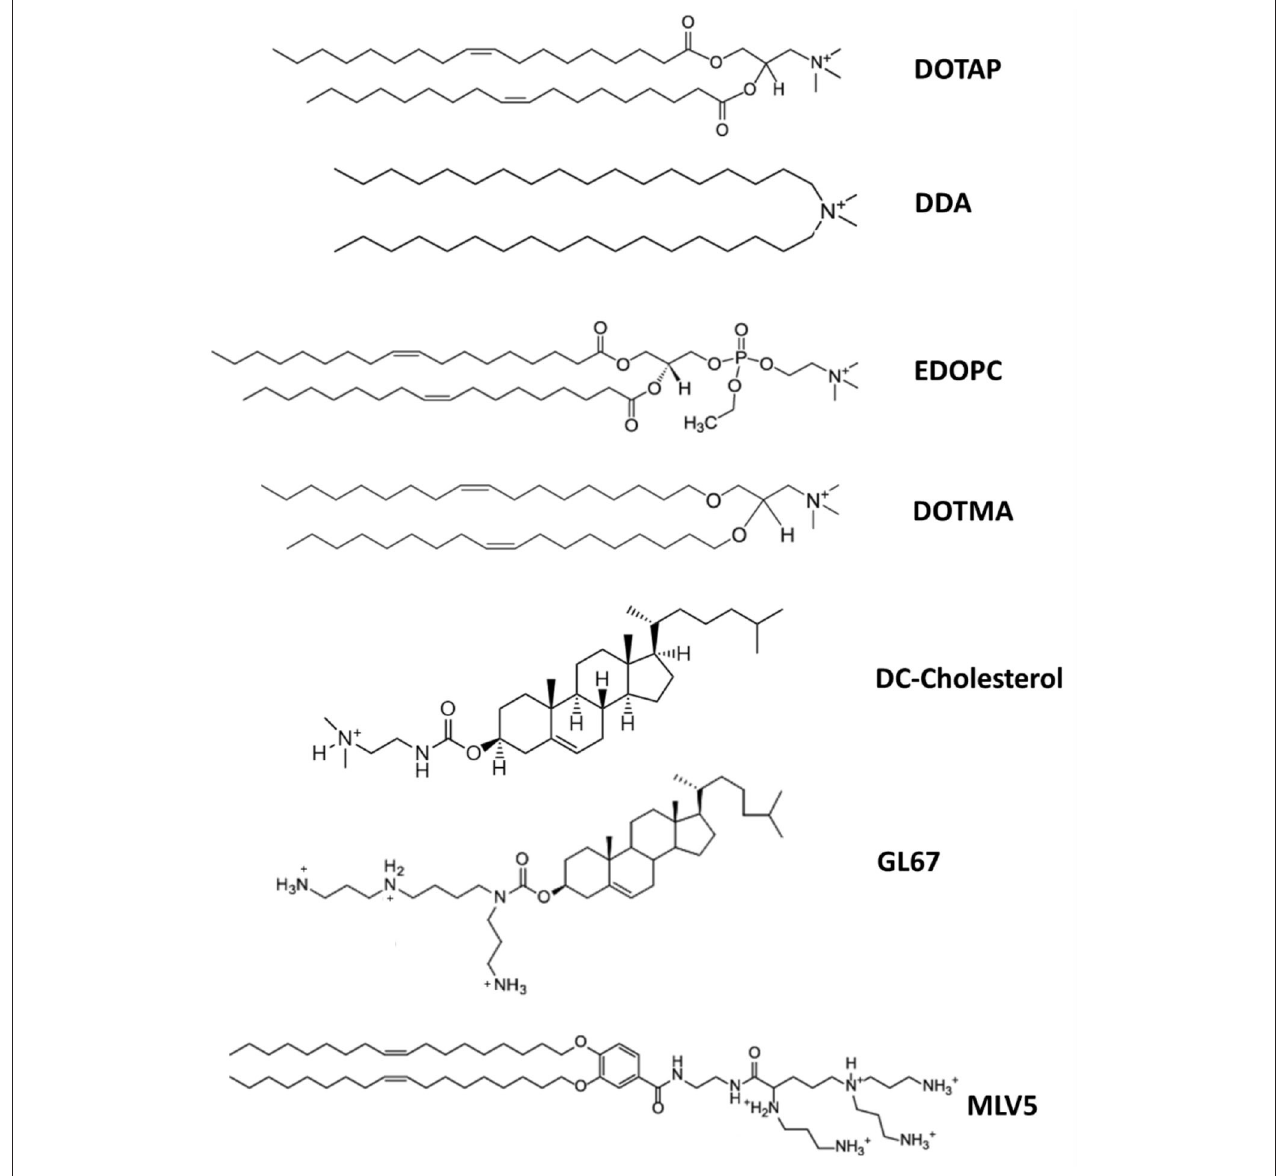
FIGURE 2 | Chemical structure of the major cationic lipids utilized for mRNA